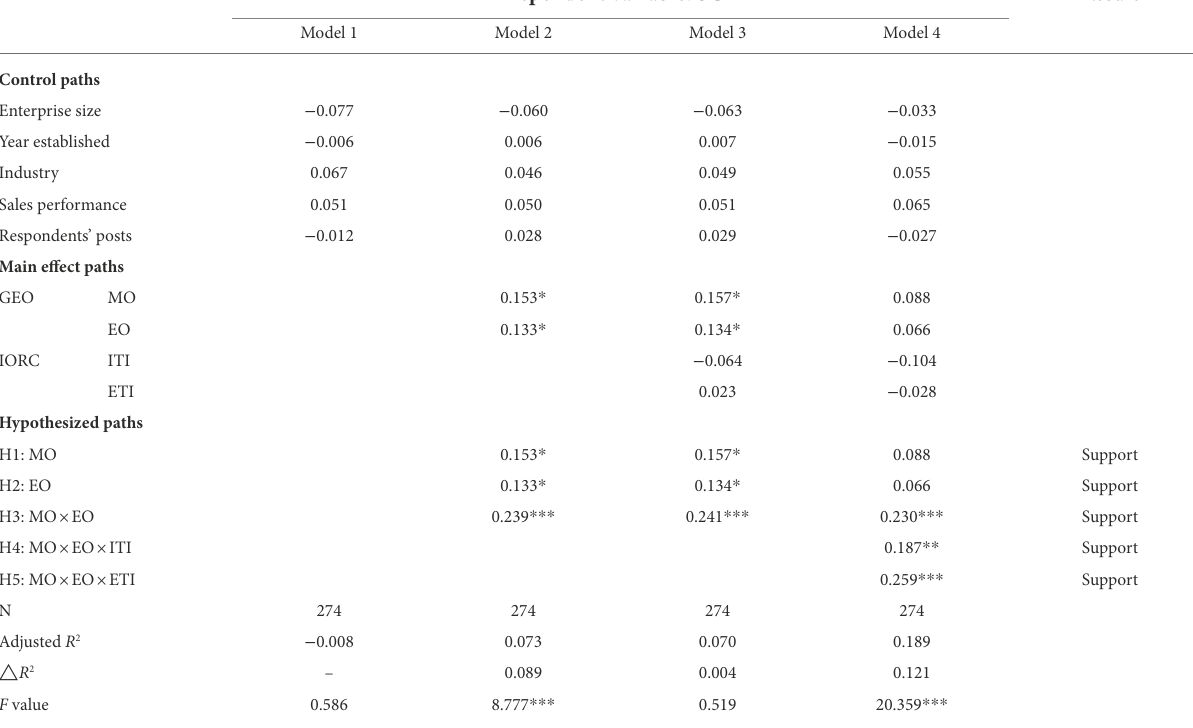
TABLE 5 Logistics regression analysis